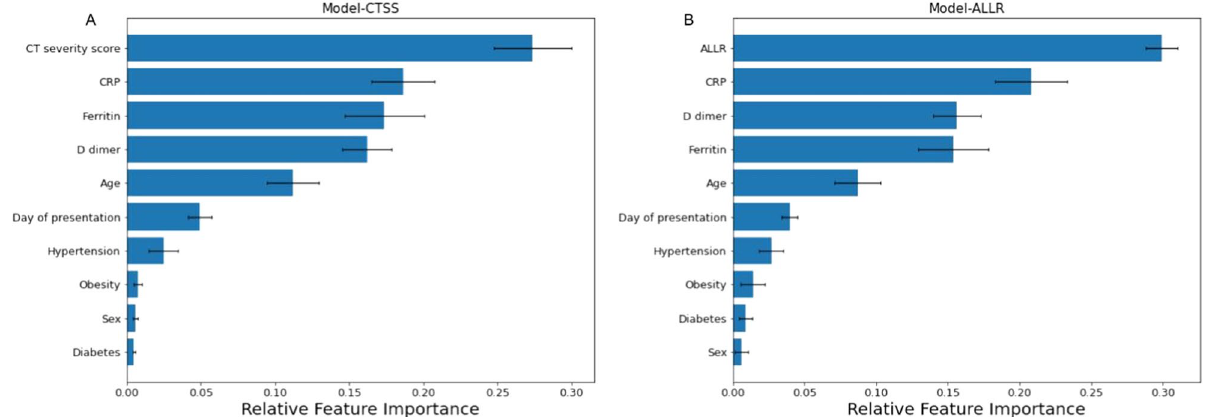
Figure 2. Relative feature importance. Panel ( A ) shows mean feature importance of the model having CT severity score and clinical parameters as the input. Panel ( B ) shows mean feature importance of the model having ALLR and clinical parameters as the input. The error bars show the standard deviations.